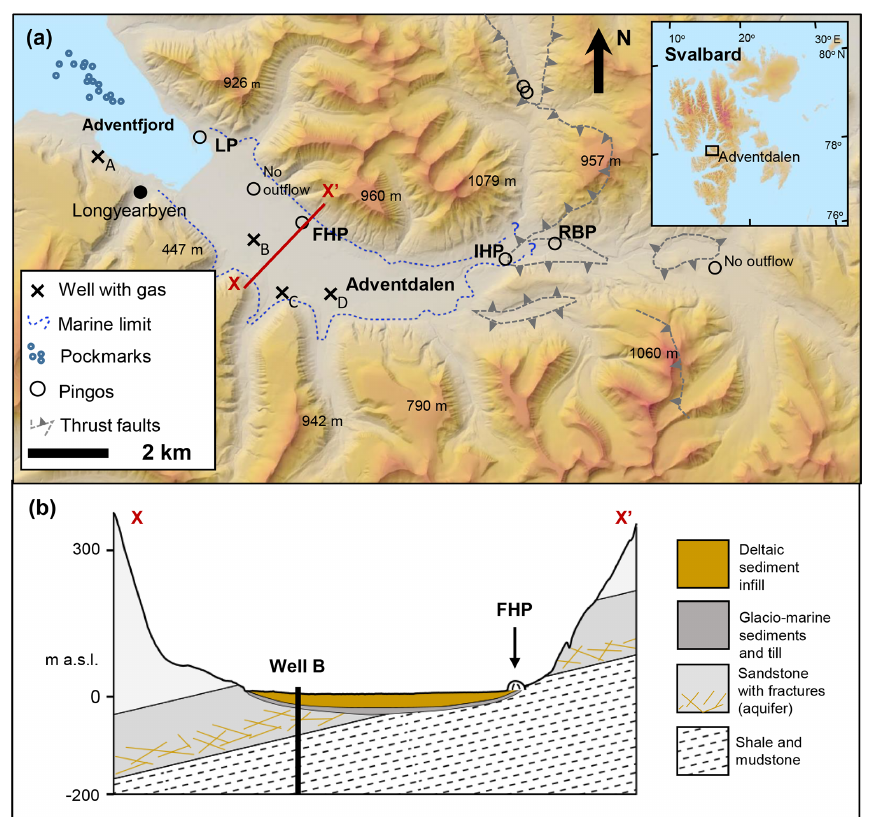
Figure 2. Adventdalen topography, pingos and geology. Active springs exist at Lagoon Pingo, Førstehytte Pingo, Innerhytte Pingo and Riverbed Pingo (LP, FHP, IHP and RBP, respectively). Well sites A and B are part of the University Centre in Svalbard (UNIS) CO 2 Well Park (Braathen et al., 2012), whilst well sites C and D are part of the Store Norske Spitsbergen Kulkompani (SNSK) operations. Map developed online at http://www.svalbardkartet.npolar.no (last access: 1 August 2018).